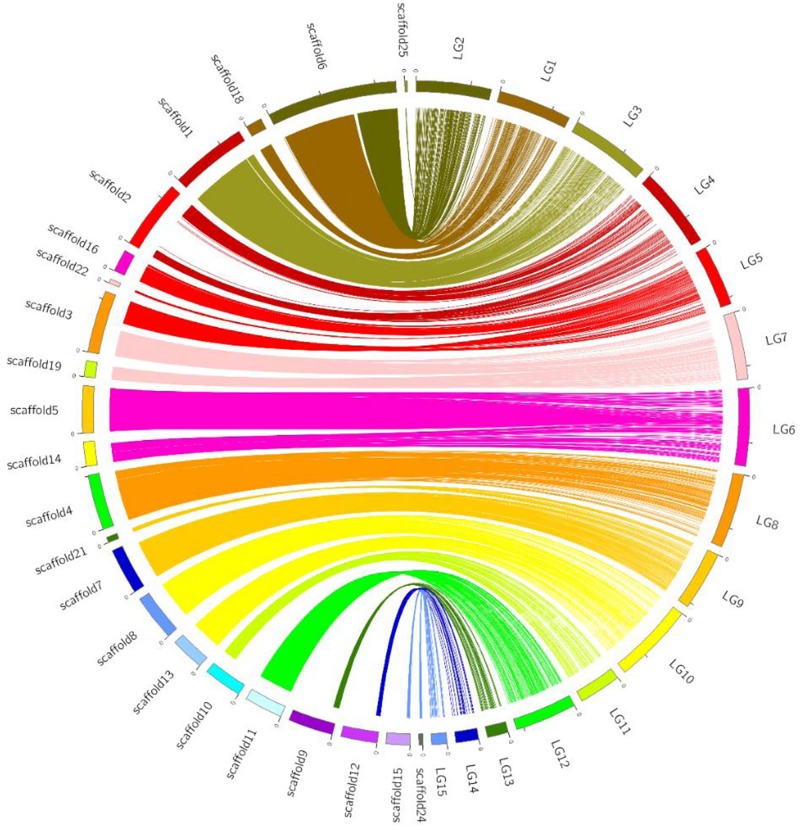
Graphical representation of the syntenic relationship between the physical and genetic maps of H. erinaceus. Linkage groups are depicted in colors at the right side of the circle, and the corresponding scaffolds are at the left side of the circle. Lines of the same colors connected the bins on LGs and physical positions on scaffolds.